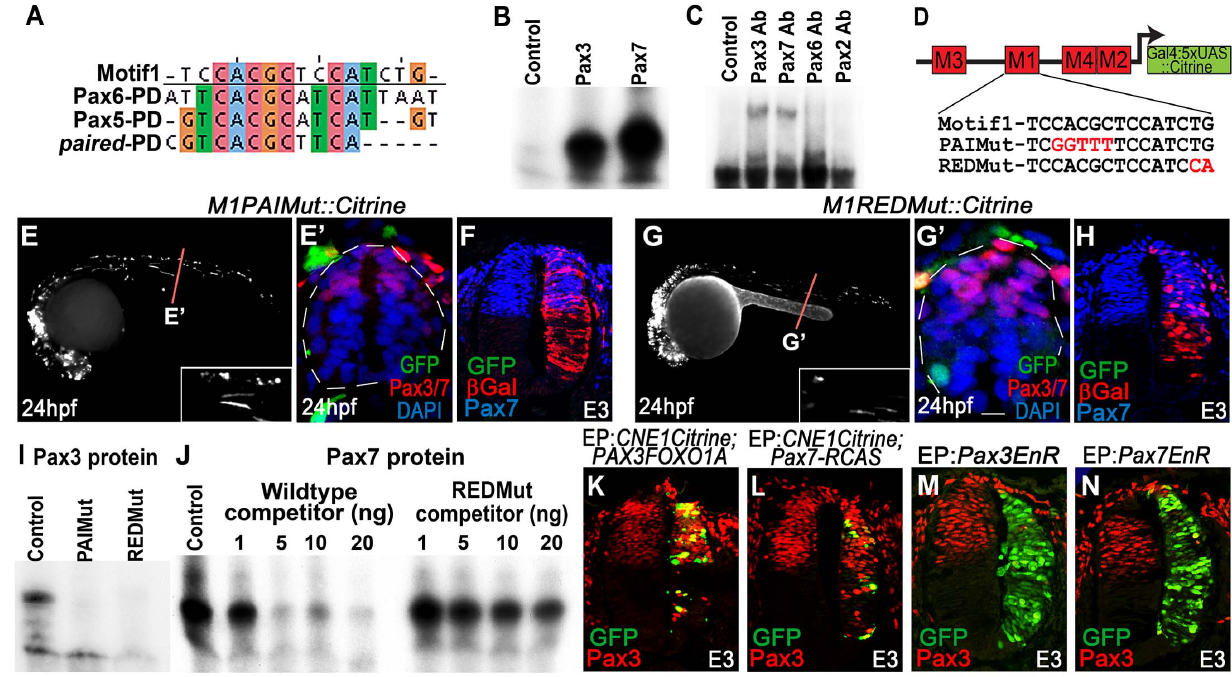
Figure 4. CNE1 mediates direct autoregulation and positive feedback via a paired domain binding site. (A) CNE1-Motif1 is homologous to the 5 9 region of defined PD binding sites, however the alignment diverges in the 3 9 region. (B) EMSA performed using Motif1 DNA and in-vitro synthesised Pax3 and Pax7 proteins, both of which can bind the sequence. (C) EMSA using Motif1 DNA and chick spinal cord nuclear extract, addition of antibodies against Pax3 or Pax7 to the reaction decreases the mobility of the DNA/protein complex. Addition of Pax6 or Pax2 antibodies does not alter the distribution of complexes within the EMSA. (D) Schematic illustrating the mutations targeted within CNE1-Motif1. (E, E 9 ) M1PAIMut transgenic zebrafish exhibit a marked reduction in CNE1 activity in spinal cord progenitors, compared to the wildtype enhancer (n=2/38, p , 0.001). (F) Mutation of the PAI domain binding site precludes CNE1 activity in the chick neural tube (n=0/8, p=0.0007). (G, G 9 ) Mutation of the RED domain binding site phenocopies Motif1 deletion in zebrafish embryos (n=0/19, p , 0.001) and chick embryos (H) (n=1/5, p=0.0128). (I) EMSAs performed using in vitro synthesised Pax3 protein and Motif1 DNA harboring either PAI or RED mutations. Mutation of either PAI or RED region precludes complex formation. (J) Competition EMSA performed using in vitro synthesised Pax7 protein, radiolabelled wildtype Motif1 DNA and non-labeled competitor probes. Non-labeled wildtype DNA effectively competes with radiolabelled probe for Pax7 binding, whereas DNA harboring the RED mutation cannot. (K) Electroporation of PAX3FOXO1A-RCAS induces ectopic CNE1 activity and Pax3 protein expression in the ventral neural tube (n=9). (L) Pax7-RCAS electroporation also induces CNE1 activity and Pax3 expression (n=7). Electroporation of dominant negative forms of Pax3 (M) (n=7) or Pax7 (N) (n=6) represses Pax3 protein expression within its endogenous